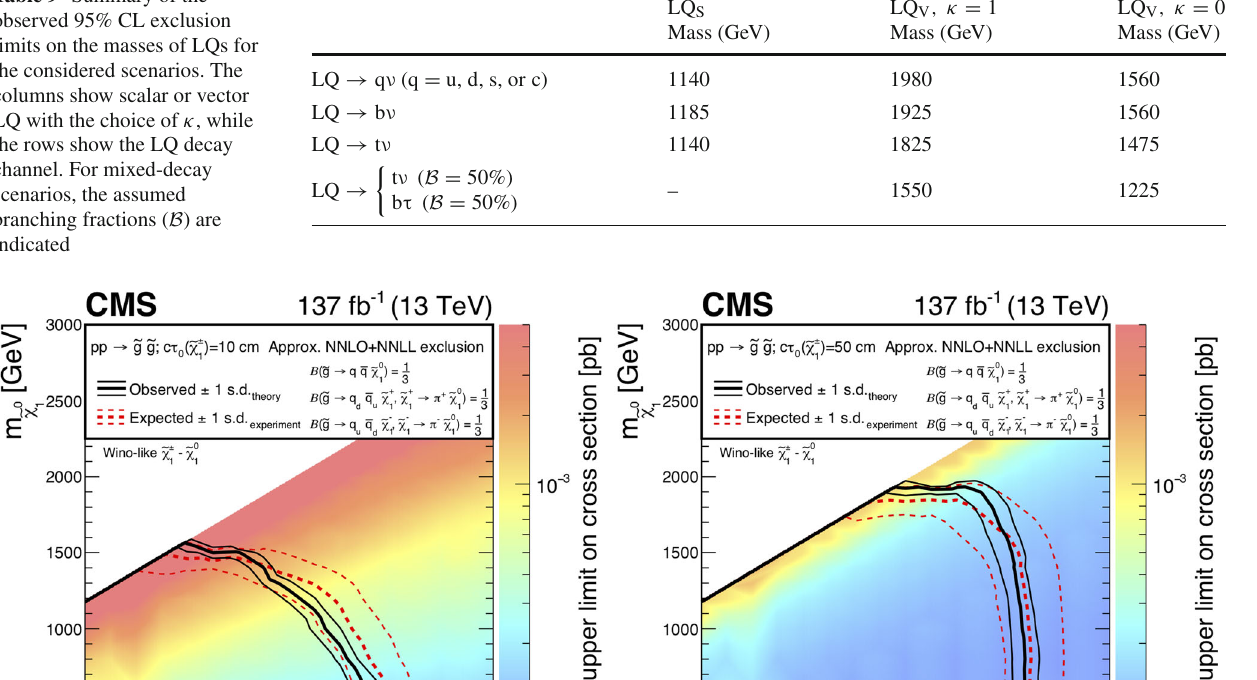
show the effect of the theoretical uncertainties in the signal cross sec- tion. The white band for masses of the ˜ χ 0 below 91.9 GeV represents 1 the region of the mass plane excluded at the CERN LEP [151]. Signal cross sections are calculated at approximately NNLO+NNLL order in α B ) as indicated in S [136–147], assuming decay branching fractions ( the